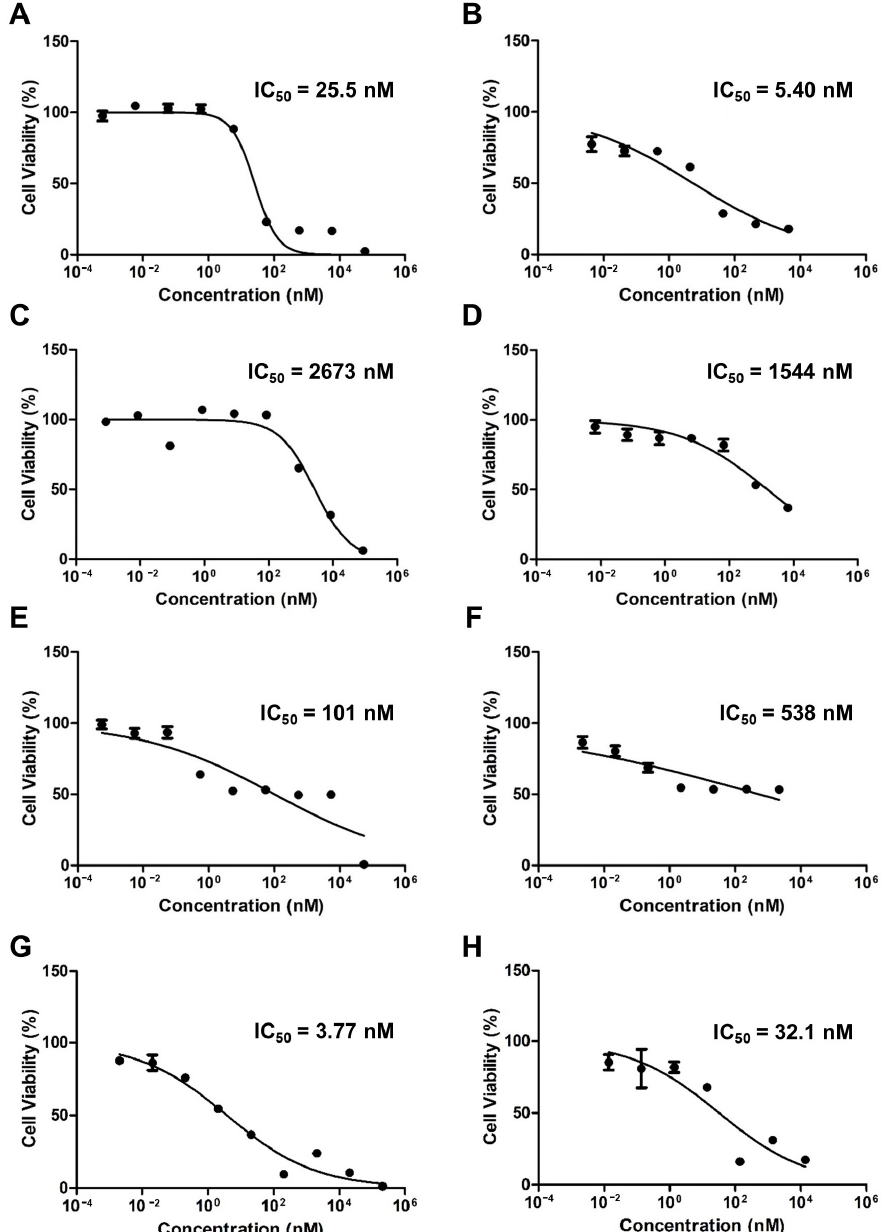
Figure 3. In vitro cytotoxicity analysis of AGS-Luc2 cells after 48 h of treatment with ( A ) free PTX, ( B ) PTX-loaded mPEG-pH-PCL micelles, ( C ) free ETP, ( D ) ETP-loaded mPEG-pH-PCL micelles, ( E ) free RAPA, ( F ) RAPA-loaded mPEG-pH-PCL micelles, ( G ) free PTX/ETP/RAPA, and ( H ) PTX/ETP/RAPA-loaded mPEG-pH-PCL micelles (n = 18).